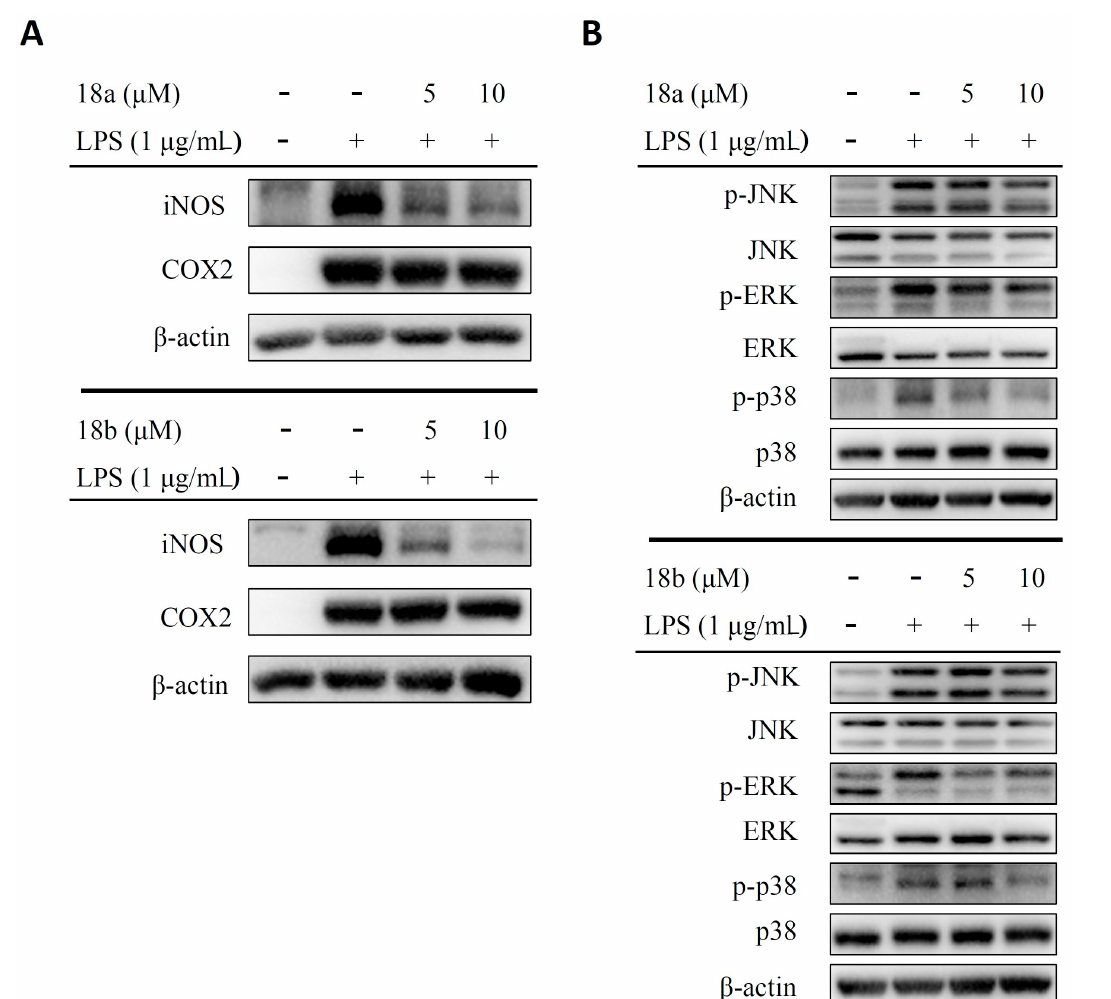
Figure 5. Effects of compounds 18a and 18b on the inducible nitric oxide synthase (iNOS), cyclooxygenase 2 (COX-2) and mitogen-activated protein kinases (MAPKs) expression by lipopolysaccharide (LPS)-activated J-blue cells. Cells were pre-treated with compounds 18a and 18b at different concentrations (0, 5 and 10 μ M) for 1 h, and then incubated with LPS (1 μ g/mL) for 2h (for MAPKs expression detection) or 24 h (for iNOS and COX-2 expression detection). ( A ) The expression of iNOS, and COX-2 was examined by Western blot. ( B ) The expression of phosphor- extracellular signal-regulated kinase (ERK), ERK, phosphor-N-terminal kinase (JNK), JNK, phosphor-p38 and p38 was measured by Western blot. Blots are representative of results obtained in three separate experiments. The expression of β -actin was used as an internal control. 2.2.5. Molecular Docking Results of 18a , 18b and TNF-á To understand the interaction between our hit compounds 18a – b and TNF-á (PDB code 2AZ5) [32,33], we performed a molecular docking study using the Achilles Blind Docking Server. The docking pose with the lowest binding energy of compounds 18a – b was shown in Figure 6. The results showed that both compounds 18a and 18b could fit into the middle of TNF-á dimer. According to the docking results, compound 18a formed hydrophobic interactions with Leu55, Tyr59, Ile 155 and pi-stacking interaction with Tyr59, while compound 18b also formed hydrophobic interaction with Leu55, Leu57 chain A and B, Tyr59, Val123 chain B and D, Ile 155. The lowest binding energy score between compound 18a , 18b and TNF-á was-7.00 and − 8.30 kcal/mol individually.